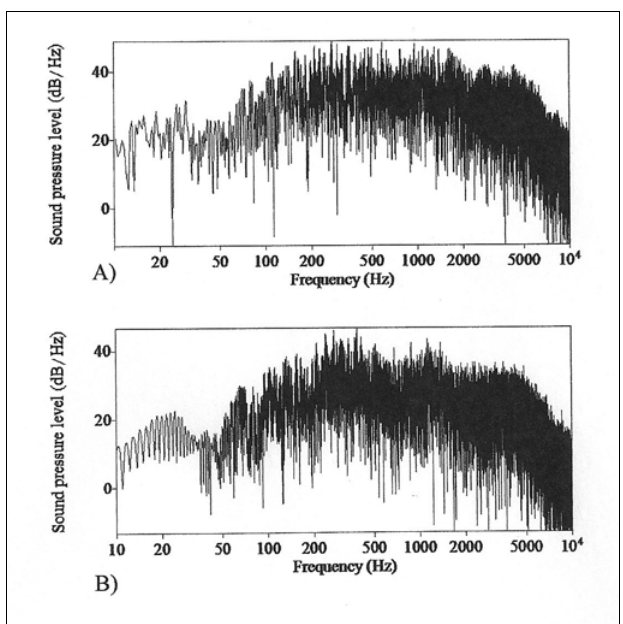
Figure 2. Praat pictures - sound pressure level density spectral graph of density distribution (dB): A - sample from the .38 revolver; B - sample from the .40